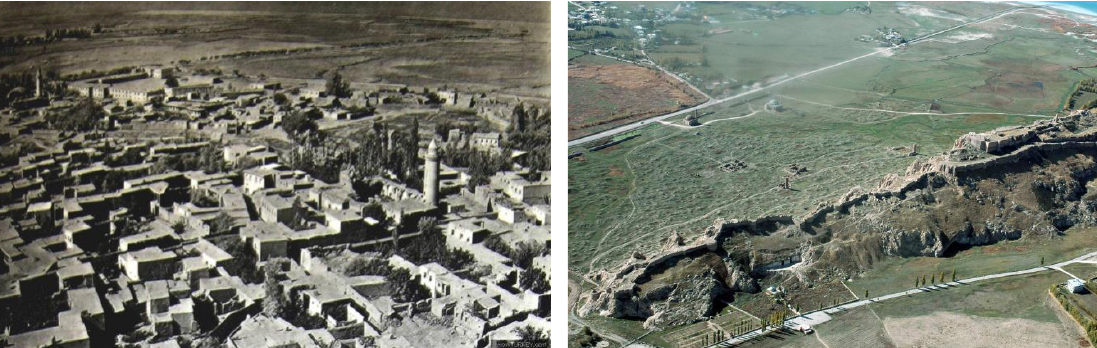
F igure 4 The Old Town of Van before 1915 (left) (Saban Ökesli and Akar , 2012, p. 29) and the situation in 2012 (right) (Saban Ökesli and Akar, 2012, p.